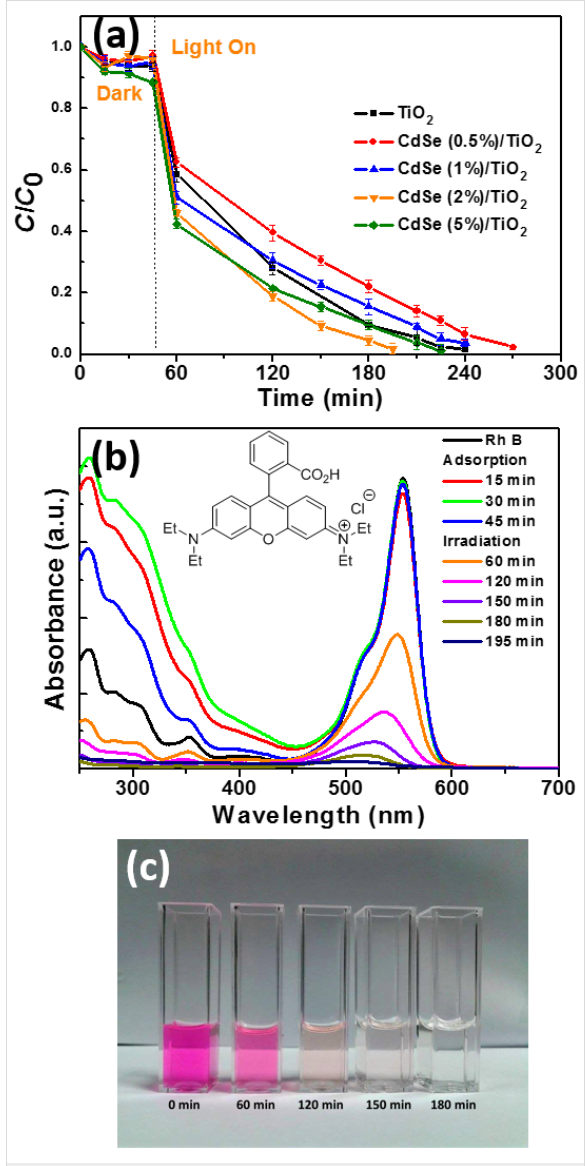
Figure 6: (a) Photocatalytic activity of TiO 2 and CdSe/TiO 2 compos- ites for the degradation of RhB under simulated solar light irradiation, (b) UV–visible absorption spectra of RhB during the photodegradation using the CdSe (2 wt %)/TiO 2 composite (the inset shows the chemi- cal structure of RhB), and (c) a digital photograph of the RhB solution over the course of the photocatalytic